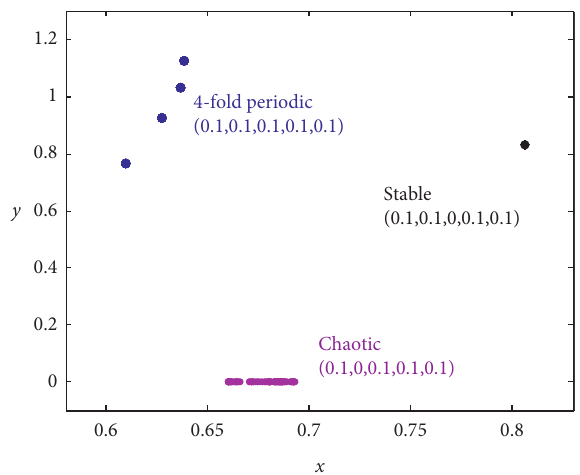
Figure 30: When a � 1, b � 1.14, c � 2.93, d � 1.3, e � 0.21, f � 0.1, g � 0.35, h � 2, α � 0.05, and β � 2, c � 0.08, multistability results of the system where the blue points denote 4-fold periodic states correspond to initial value (0.1, 0.1, 0 .1, 0.1, 0.1), the black point denotes a stable state of equilibrium point corresponding to initial value (0.1, 0.1, 0, 0.1, 0.1), and the rose points denote chaotic state corresponding to initial value (0.1, 0, 0.1, 0.1,